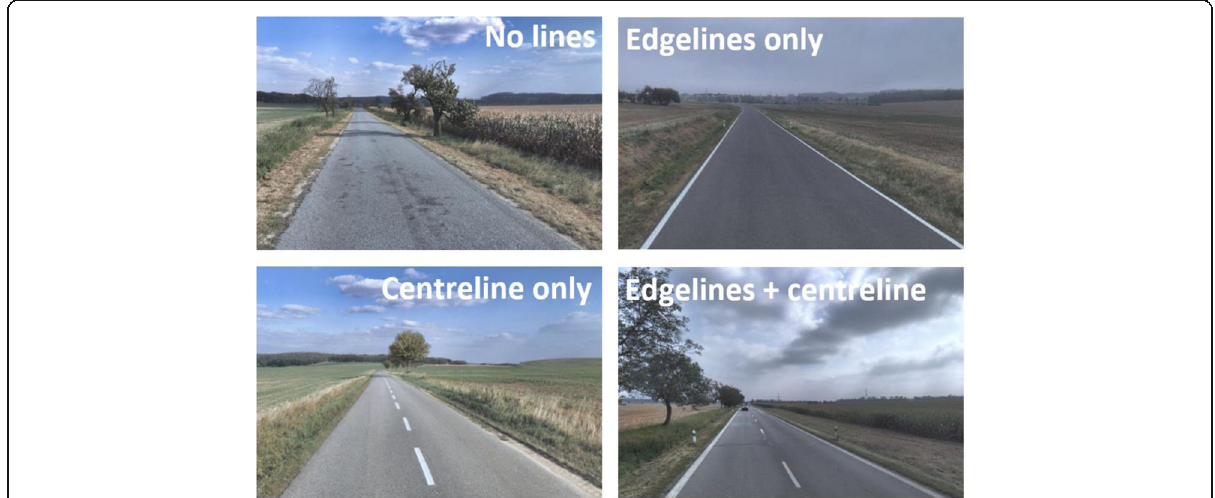
Fig. 1 Example photographs of Czech rural road marking scenarios (adapted from